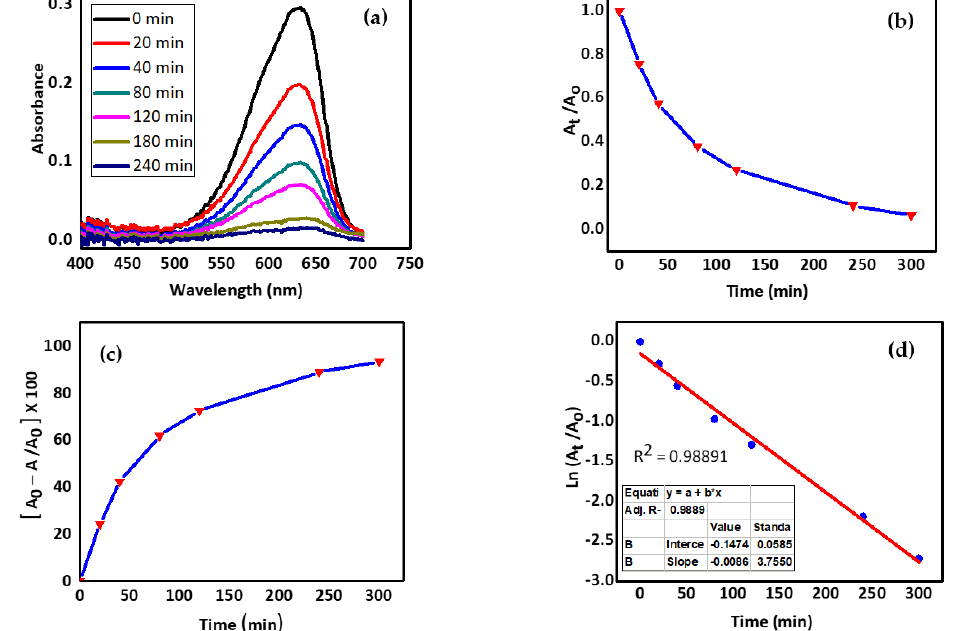
Figure 9. Summary for the degradation of Nile blue in the presence of 0.1 g of CuO–SiO 2 particles under light. ( a ) Variation in UV-Visible spectra/absorbance at different intervals of time, ( b ) ratio of absorbance (A t /A 0 ) versus time, ( c ) % decomposition versus time and ( d ) characteristic plot for pseudo-first-order kinetics of degradation.